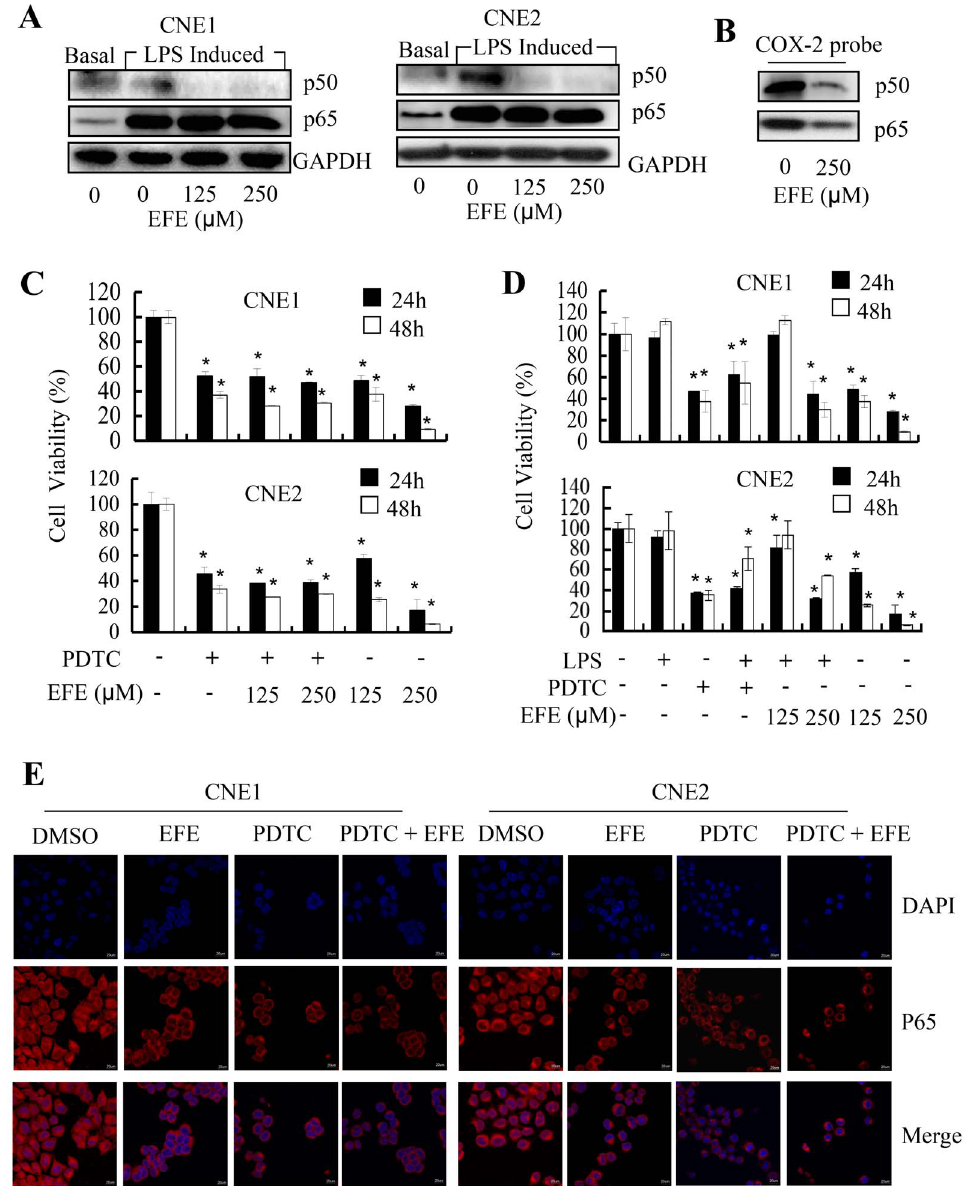
Figure 5. Effusanin E affects the activity of the NF- k B pathway. ( A ) Effusanin E inhibited the expression of p50 and p65. NPC cells were treated with DMSO (basal) or LPS (2 m g/ml) for 8 hours followed by effusanin E treatment at125 m M or 250 m M (EFE 125 m M or EFE 250 m M) for up to 24 hours. At the indicated time points, the cells were detected by Western blot analysis. ( B ) The binding of p50 and p65 NF- k B to the biotin-labeled, COX-2 promoter probe was analyzed by streptavidin-agarose pulldown assays, and the levels of p50 and p65 protein expression were detected by Western blot analysis. ( C ) The effect of effusanin E was inhibited by an inhibitor of NF- k B in NPC cells. NPC cells were treated with PDTC (100 m M) for 8 hours followed by effusanin E at 125 m M and 250 m M (EFE 125 m M or EFE 250 m M) treatment for up to 24 hours or 48 hours. At the indicated time points, the cells were analyzed using the MTS assay. ( D ) The effect of effusanin E was blocked by an activator of NF- k B. NPC cells were treated with LPS (2 m g/ml) or ammonium pyrrolidinedithiocarbamate (PDTC) (100 m M) for 8 hours followed by effusanin E at125 m M or 250 m M (EFE 125 m M or EFE 250 m M) treatment for up to 24 hours or 48 hours. At the indicated time points, the cells were analyzed using the MTS assay. ( E ) Analysis of the reduced nuclear translocation of NF- k B p65 by immunofluorescence imaging (IFI). CNE1 and CNE2 cells were treated with effusanin E at 125 m M (EFE) or PDTC (100 m M) or PDTC (100 m M) for 8 hours followed by effusanin E at 125 m M (PDTC + EFE), and NF- k B nuclear translocation in CNE1 and CNE2 cells was determined by immunofluorescence imaging analysis. * represent P ,